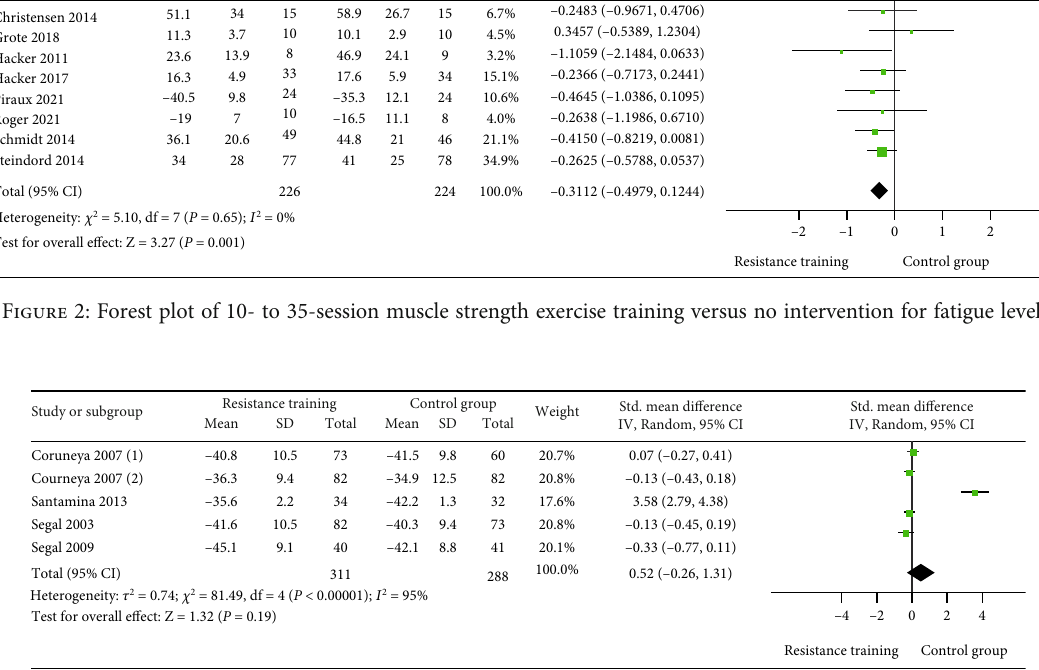
Figure 3: Forest plot of greater than 36-session muscle strength exercise training versus no intervention for fatigue